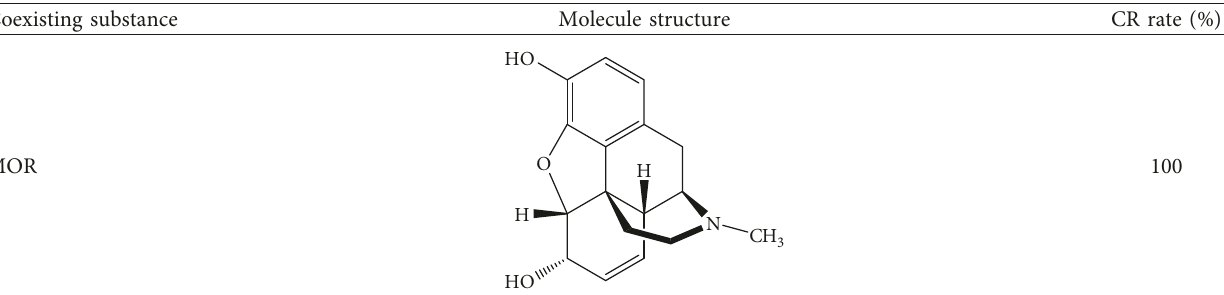
Table 3: Cross reactivity of MOR structurally similar